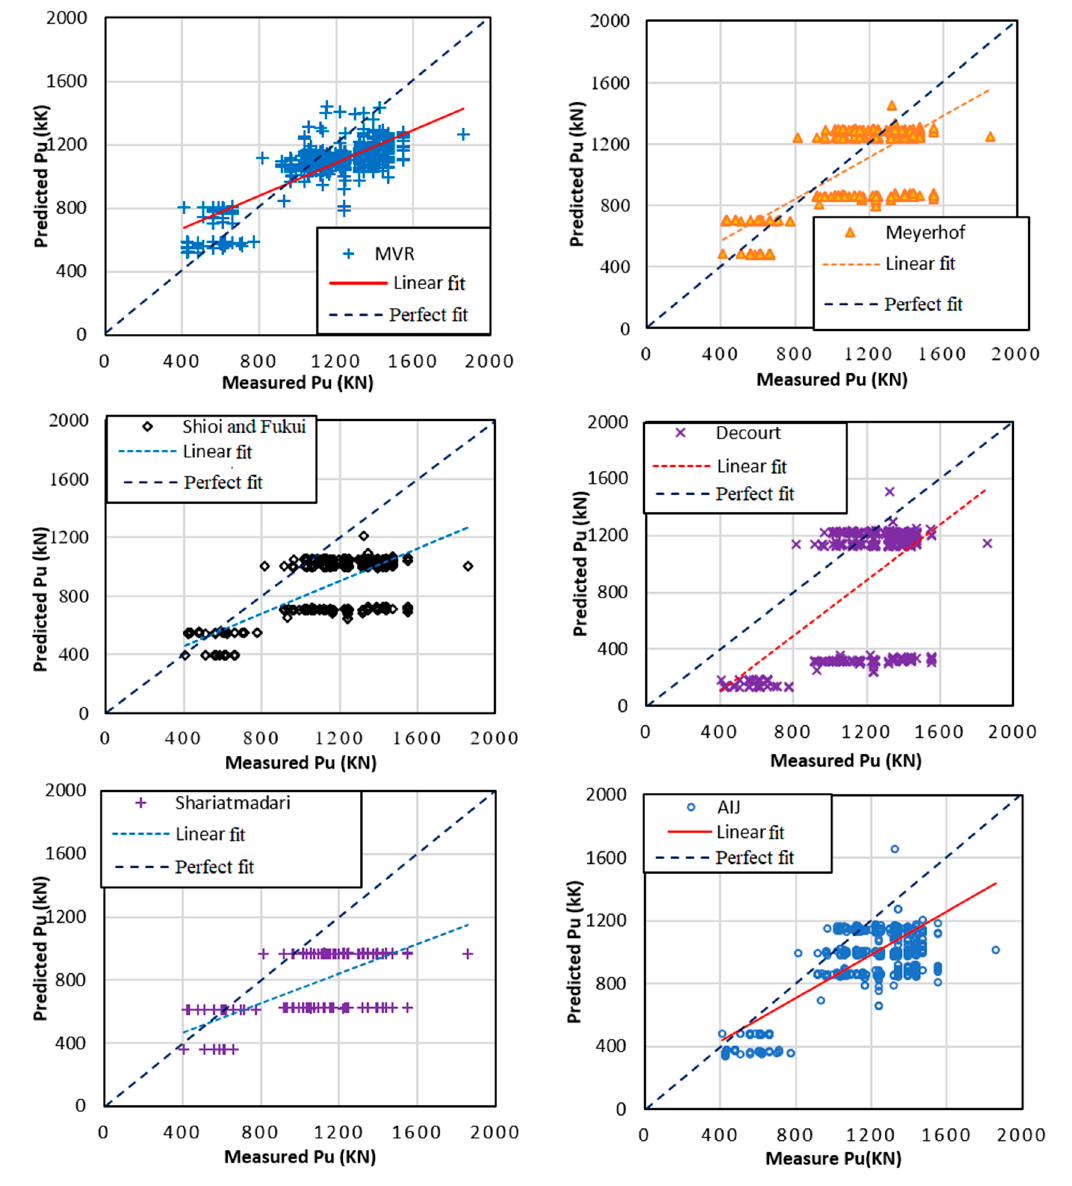
Figure 9. Comparisons of pile bearing capacity prediction methods. Table 9. Summary of different pile bearing capacity prediction methods